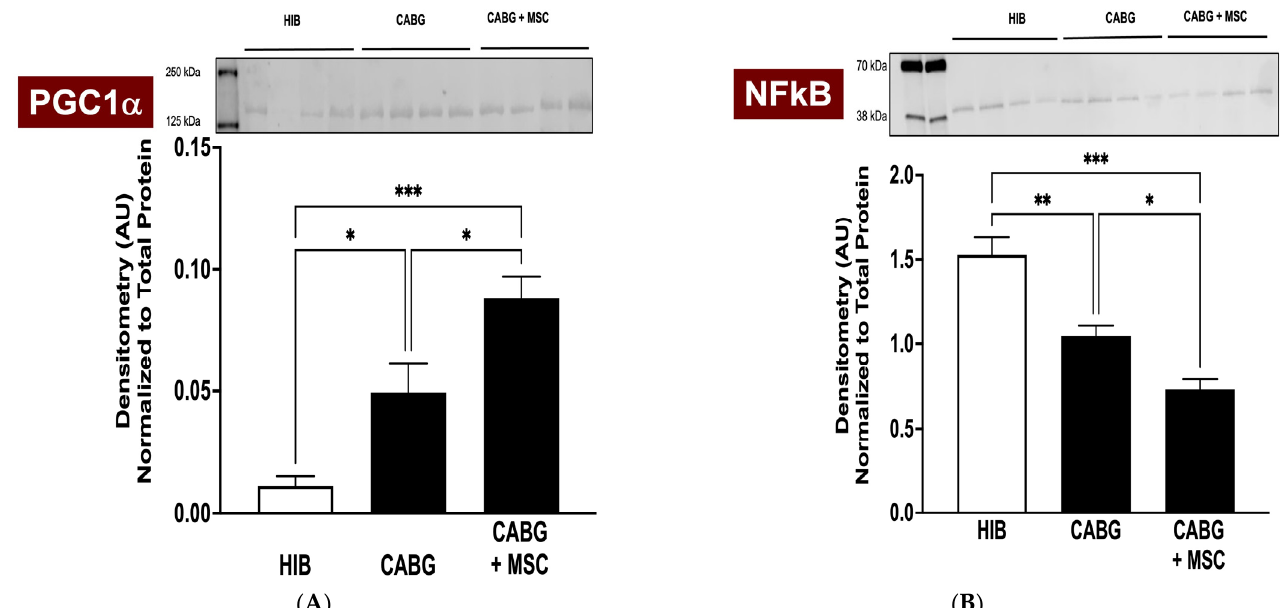
Figure 3. Western Blot analyses of PGC1 α and NF κ B. Porcine LAD tissue was obtained from three experimental groups (HIB, CABG, and CABG + MSC) to analyze the protein signal. ( A ) Western blots of CABG + MSC myocardial tissue show a dramatic increase in PGC1 α compared to the HIB (*** p < 0.001) and CABG-only groups (* p < 0.05). ( B ) The expression of NF κ B was measured in three experimental groups and was found to have a statistically significant decrease in CABG + MSC compared to the HIB (*** p < 0.001) and CABG groups (* p < 0.05). All protein level measurements were normalized to a total protein stain to correct for loading variability. One-way analysis of variance (ANOVA) and Tukey’s multiple comparison test were used for statistical analyses. Data are presented as the means ± SEM. * p < 0.05; ** p < 0.01, *** p < 0.001. CABG = Coronary artery bypass graft, HIB = Hibernating myocardium, MSC = Mesenchymal Stem Cells, NF κ B = Nuclear Factor Kappa-Light-Chain Enhancer of Activated B Cells, PGC1 α = Peroxisome Proliferator-Activator Receptor Gamma Coactivator 1-Alpha.